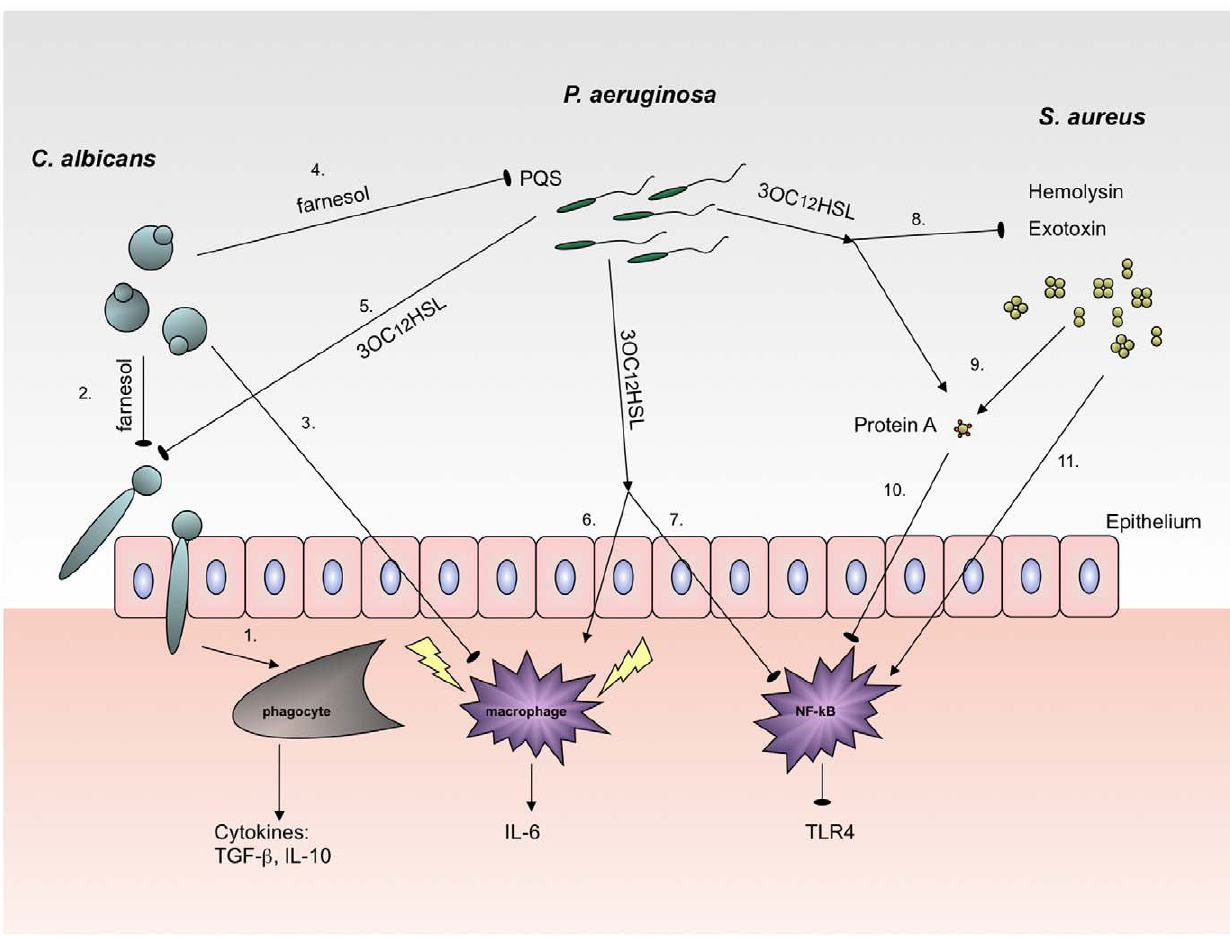
Figure 2. Effects of 3OC 12 HSL on P.aeruginosa , S.aureus , and C.albicans that are relevant to immune recognition. Lines ending in arrows indicate induction and lines ending in circles indicate inhibition of the indicated process. C. albicans , in the hyphal morphology, induces phagotycosis during inflammation (1). Virulent hyphae can be inhibited and transformed to yeast cells by farnesol, the QS molecule secreted by C. albicans (2). Candida yeast cells prevent macrophages induction (3) and render C. albicans invisible for the immune system. C. albicans coexisting with P. aeruginosa exerts a double-sided reaction; farnesol inhibits Pseudomonas QS production (4), whereas 3OC 12 HSL secreted by P. aeruginosa prevents C. albicans filamentation without changing the growth rate (5). 3OC 12 HSL sensed by the host induces a pro-inflammatory response by activation of macrophages (6), but it can also give an anti-inflammatory reaction by selectively diminishing the regulation of NF- k B signaling and attenuating TLR4-dependent innate immune responses (7). P. aeruginosa 3OC 12 HSL influences S. aureus by inhibiting growth and hemolysin and exotoxin production (8) and by inducing protein A expression (9), which prevents recognition of S. aureus by macrophages and neutrophils (10). S. aureus detected by the immune system trigger macrophages signaling pathways (11).